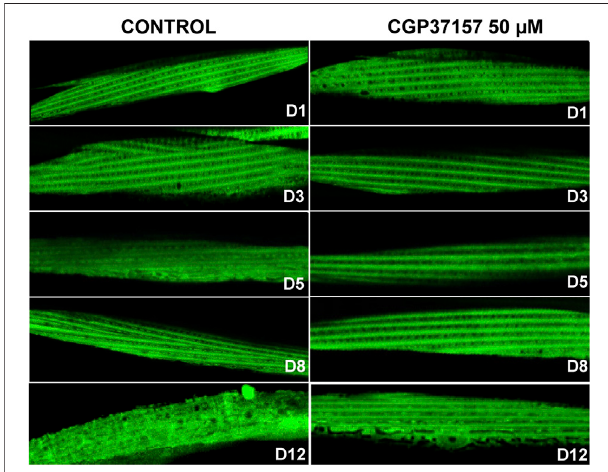
FIGURE 5 | Effect of CGP37157 on the sarcomeric structure in C. elegans body wall muscle during aging. AQ2121 worms, expressing the YC2.1cameleonprobeinthecytosol,wereimagedbyconfocalmicroscopyat different days of adult life, either treated or not with 50 µM CGP37157 since day 1 of adult life.